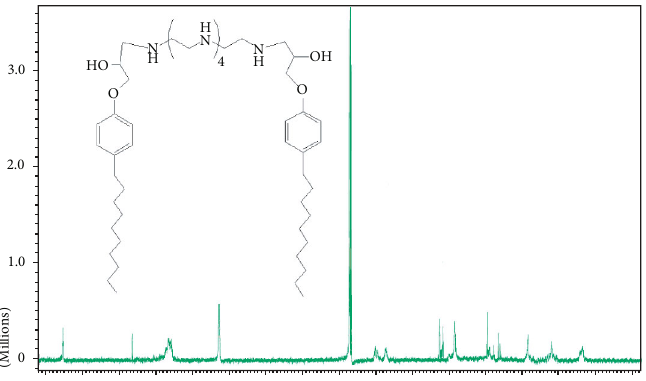
Figure 2: 13 C-NMR spectra of NTEPA.